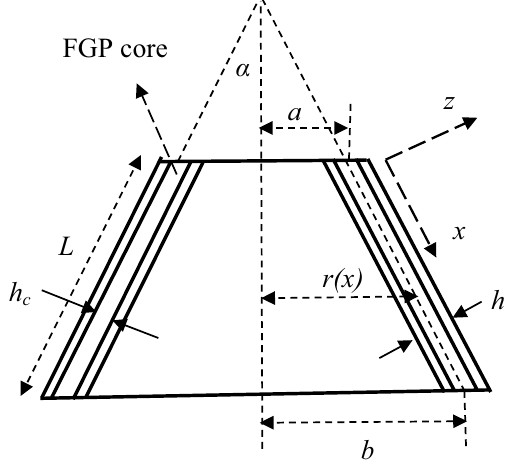
Figure 1. A sandwich truncated conical shell with an FGP core.